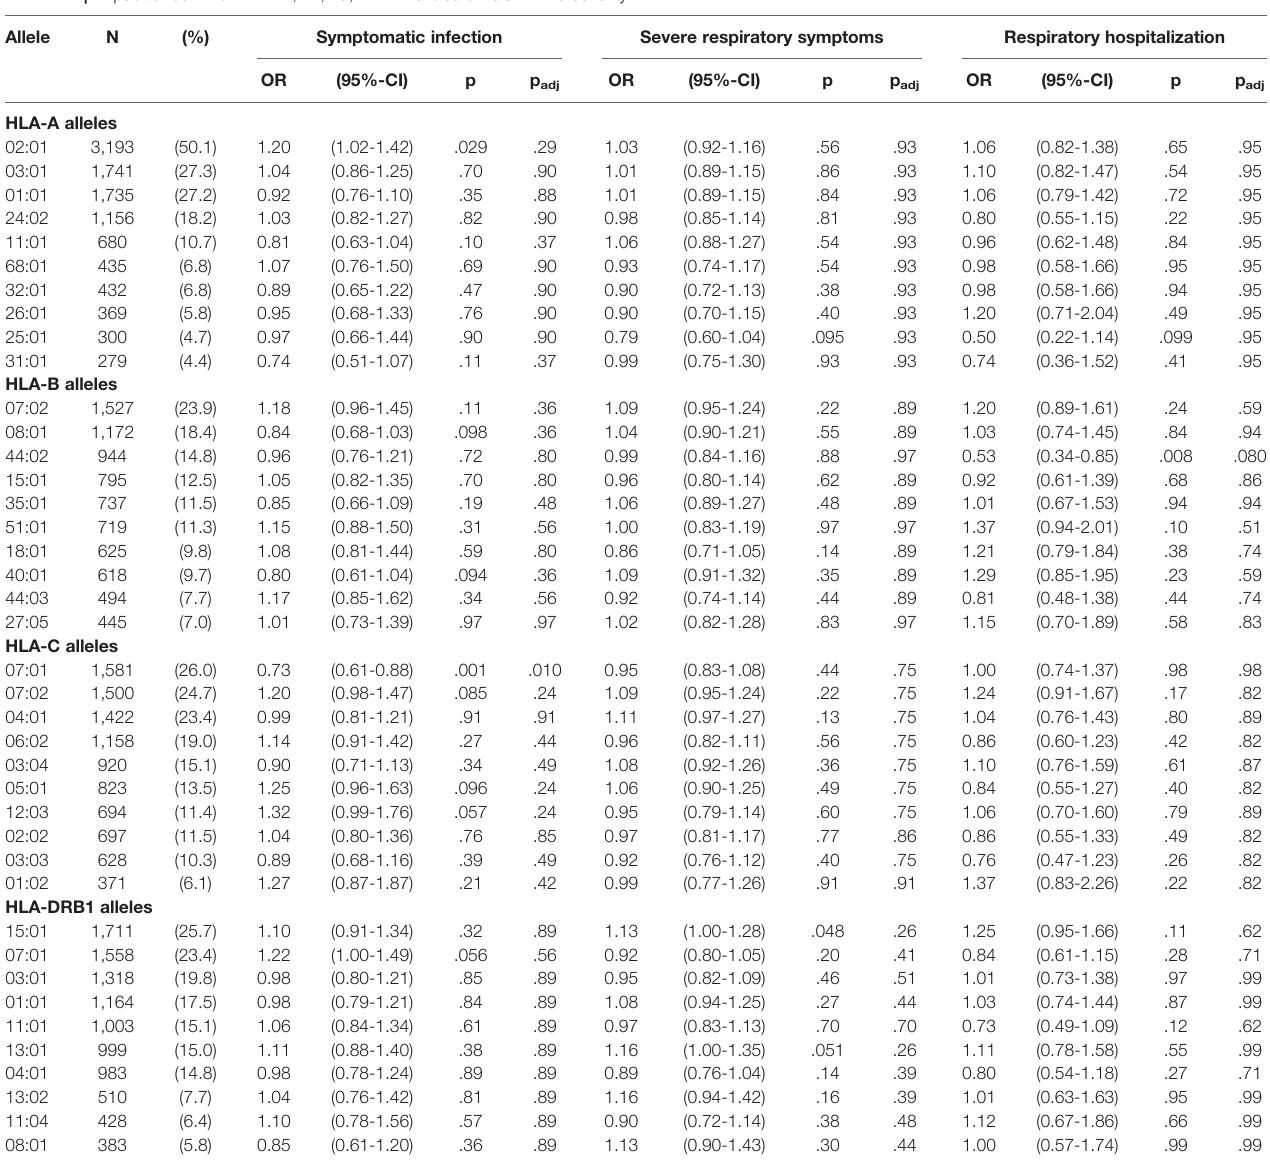
TABLE 2 | Impact of common HLA-A, -B, -C, -DRB1 alleles on COVID-19 severity.